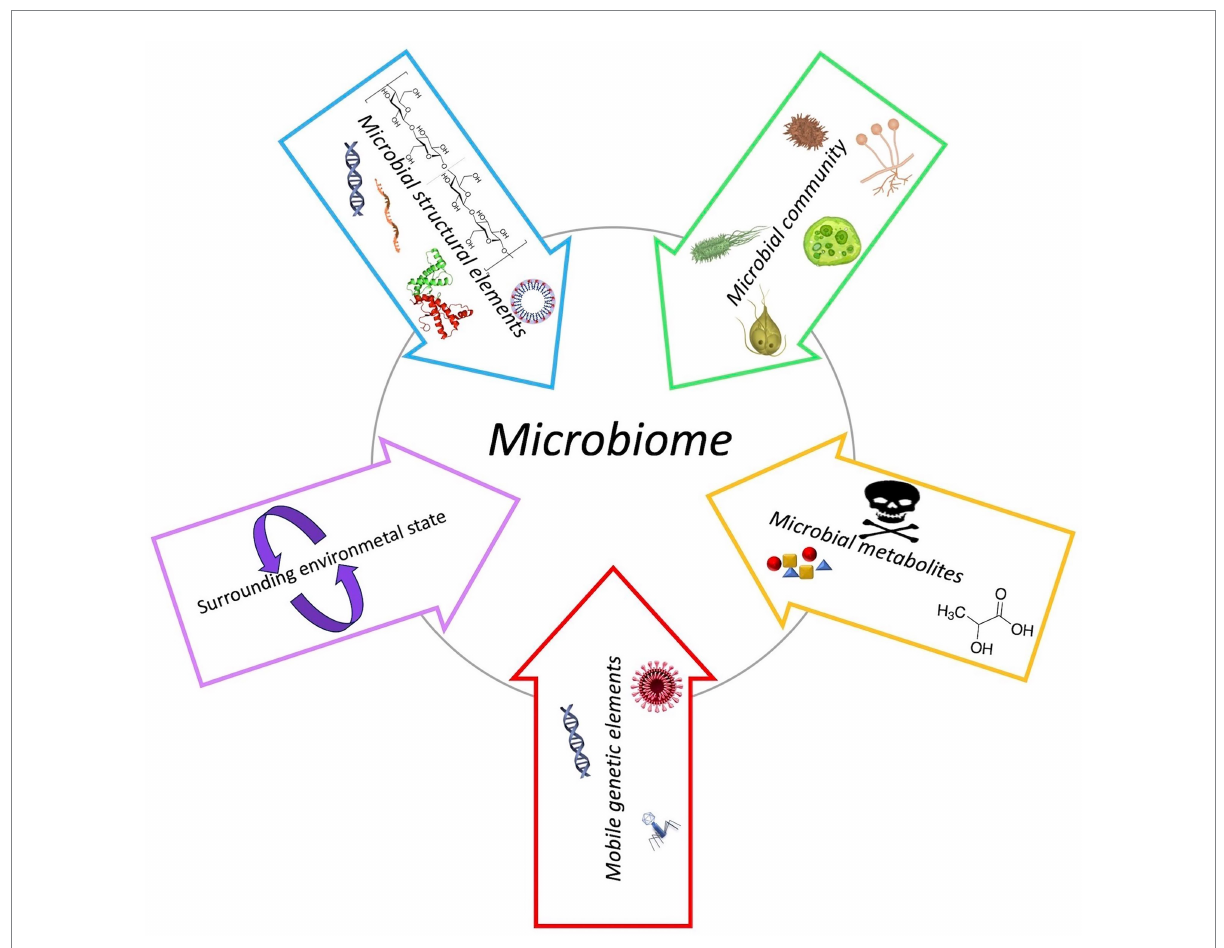
FIGURE 1 Schematic composition of